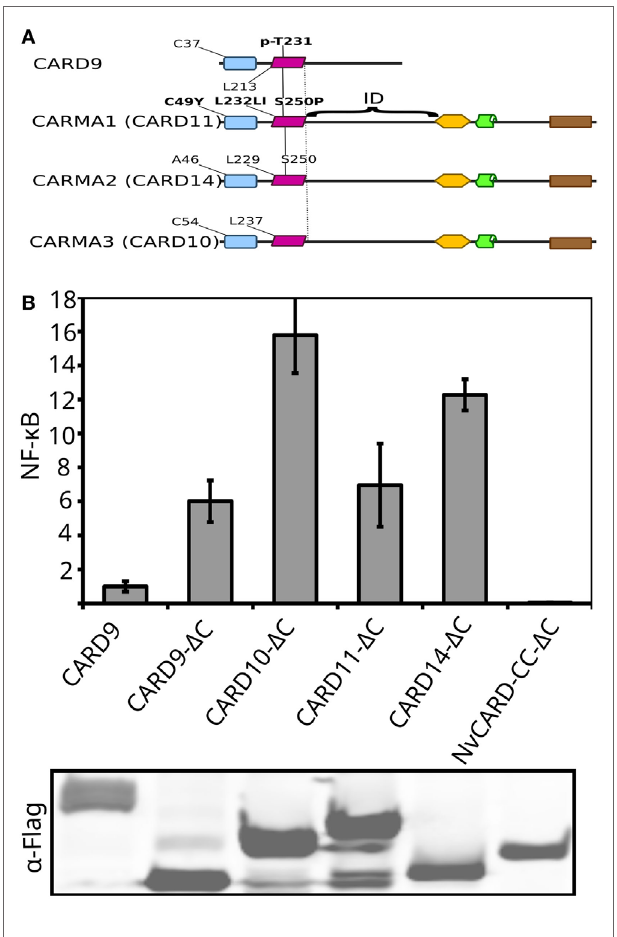
FigUre 6 | Activation by C-terminal deletions of the CARD–Coiled Coil (CC) protein family members. (a) Structural features of the four mammalian CARD–CC family proteins, activating mutations/modifications in conserved residues, are highlighted in bold text. C-terminal deletion mutants in (B) consist of the CARD (blue) and CC (purple) domains, to the left of the dashed line. (B) Mutants of CARD–CC family members with C-terminal deletions were expressed in human HEK293T cells together with an NF- κ B-dependent luciferase reporter gene and a constitutively expressed β -galactosidase reporter gene plasmids. Luciferase values were normalized against β -galactosidase and expressed as fold induction compared to full-length (with intramolecular repression)